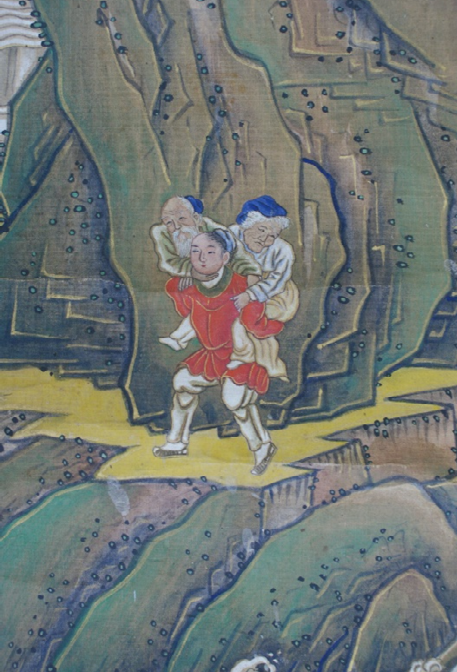
Figure 16. Detail of Three Gates in a Single Mind showing the scene of going around Mount Sumeru in the left frame. Photograph by Choi Yeub.